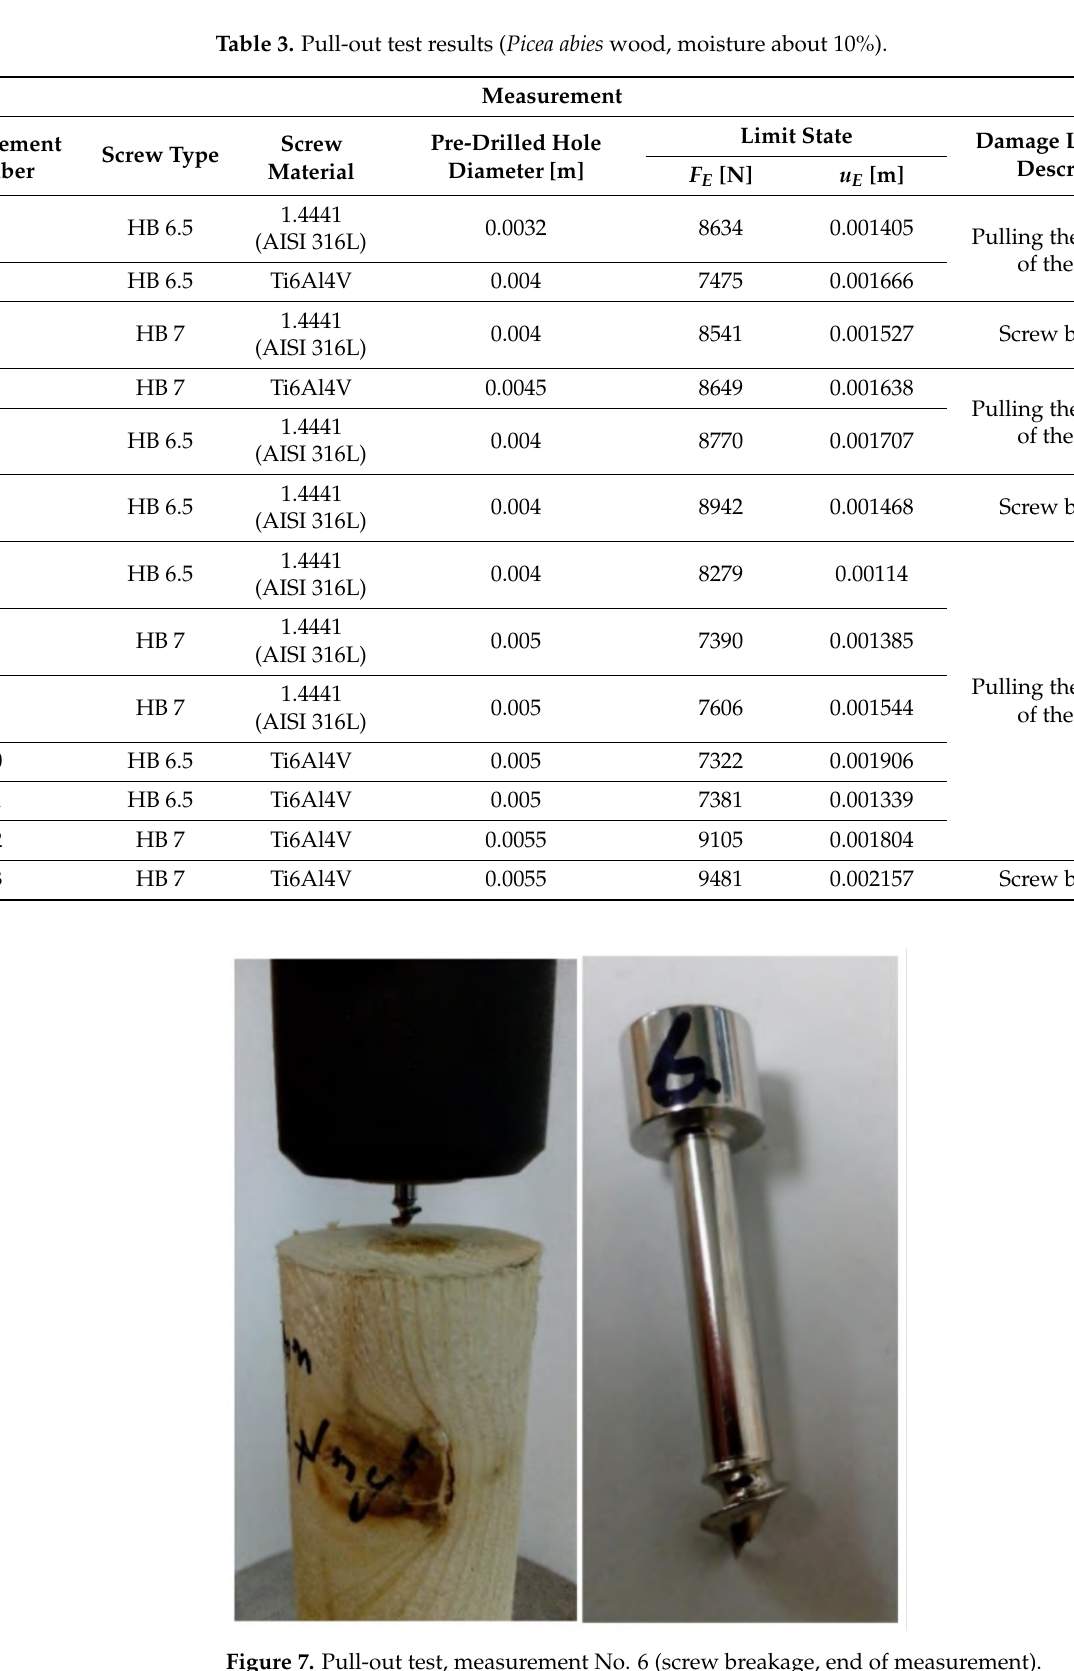
Figure 7. Pull-out test, measurement No. 6 (screw breakage, end of